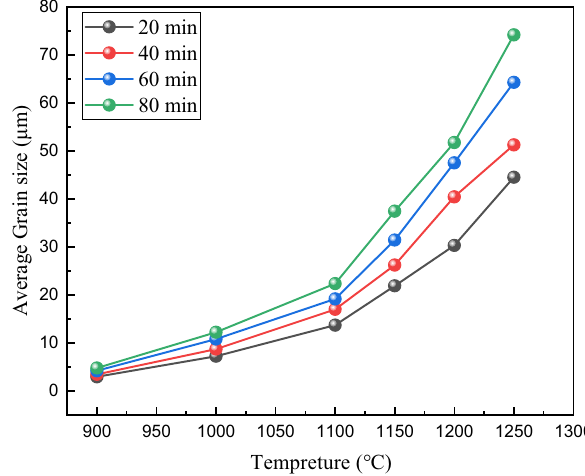
Figure 4: The relationship between average austenite grain size and temperature of experimental